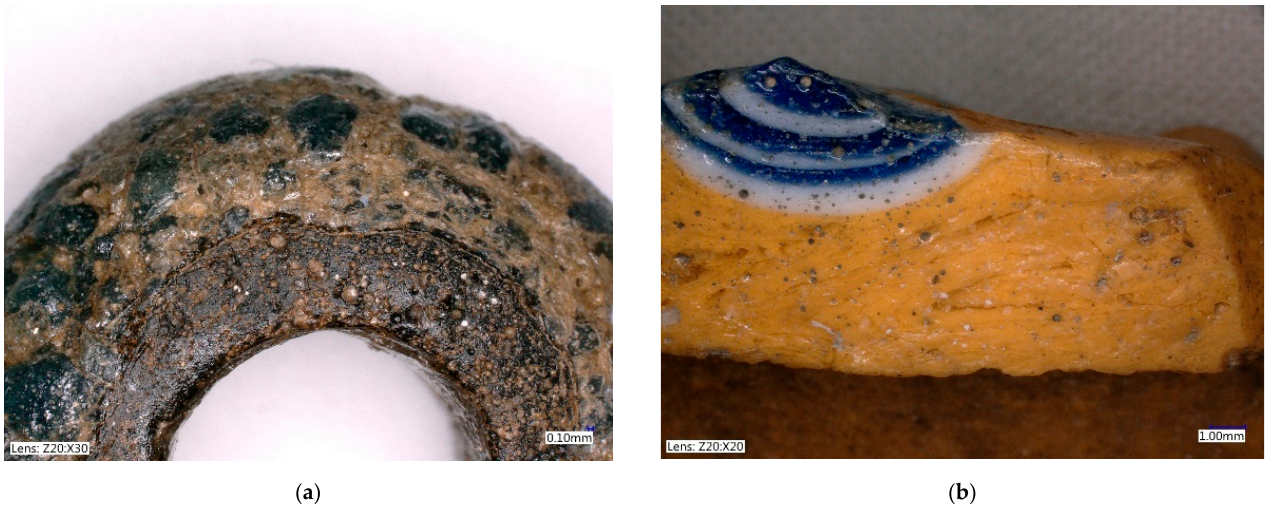
Figure 4. Inhomogeneity of examined beads. ( a ) Bead No. 11, double layer structure; ( b ) Bead No. 23, apparent direction of shaping.